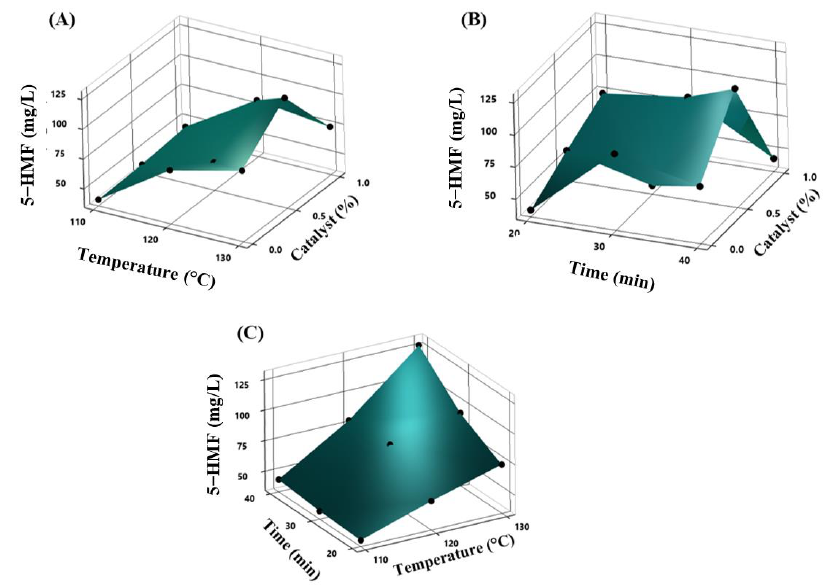
Figure 1. Response surface plots showing the increase in 5-HMF with ( A ) the effects of temperature and time, ( B ) the action of temperature and catalyst, and ( C ) the interaction of time and the catalyst after the treatments.